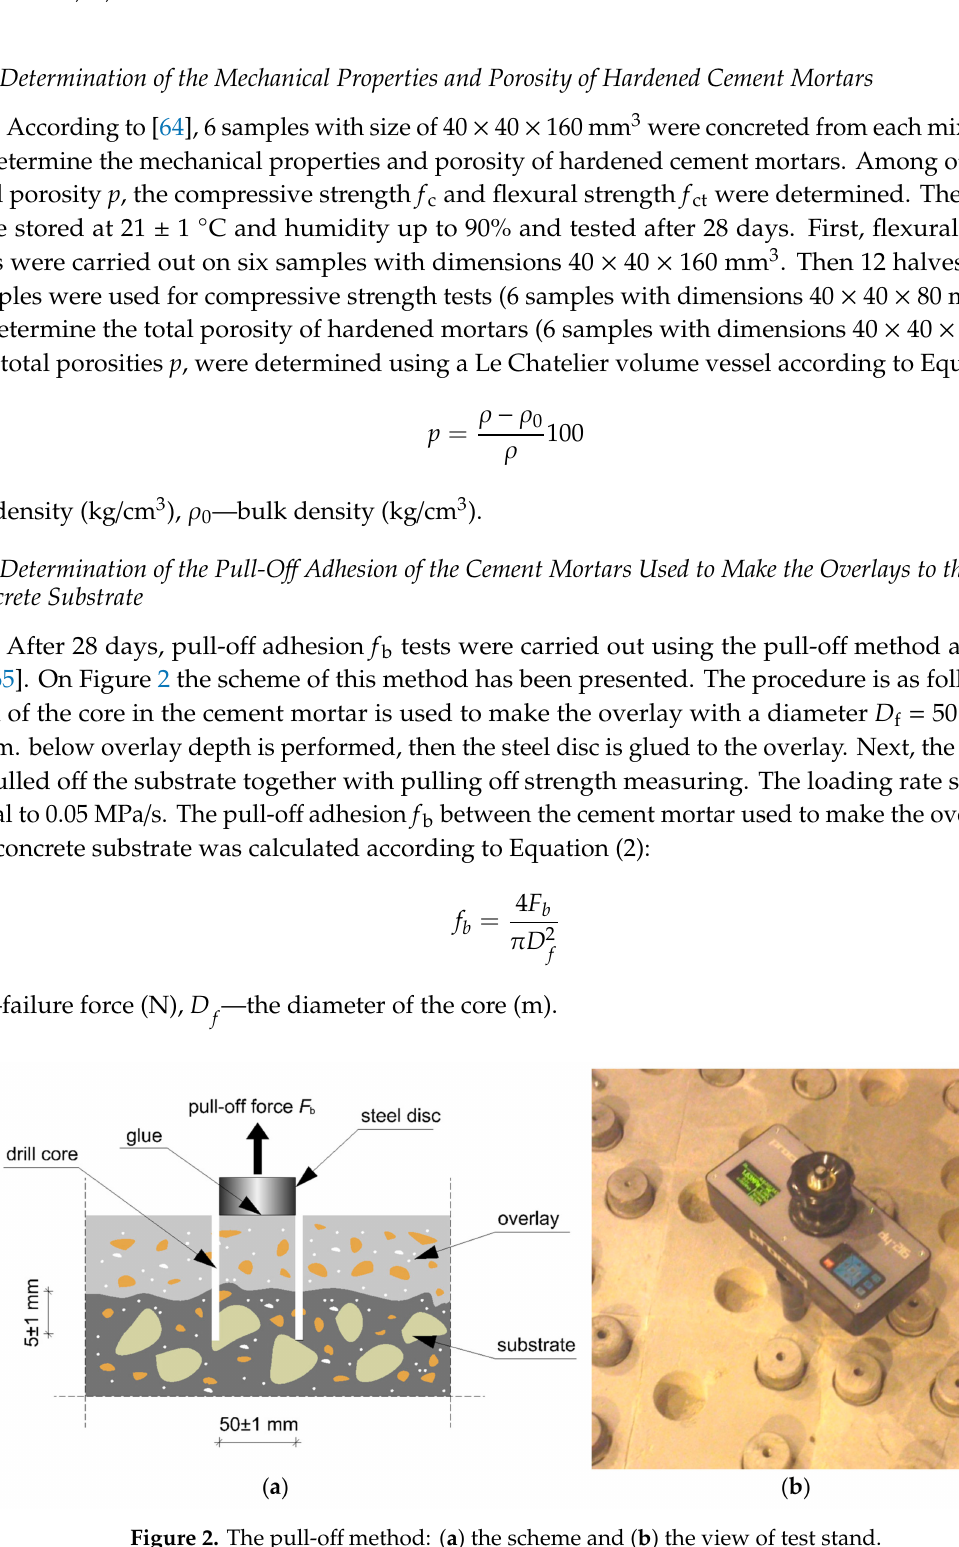
Figure 2. The pull-o ff method: ( a ) the scheme and ( b ) the view of test